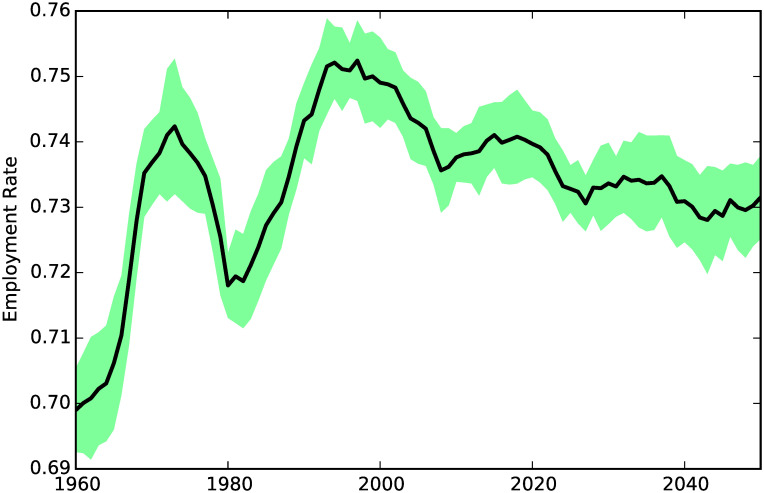
Employment rate.